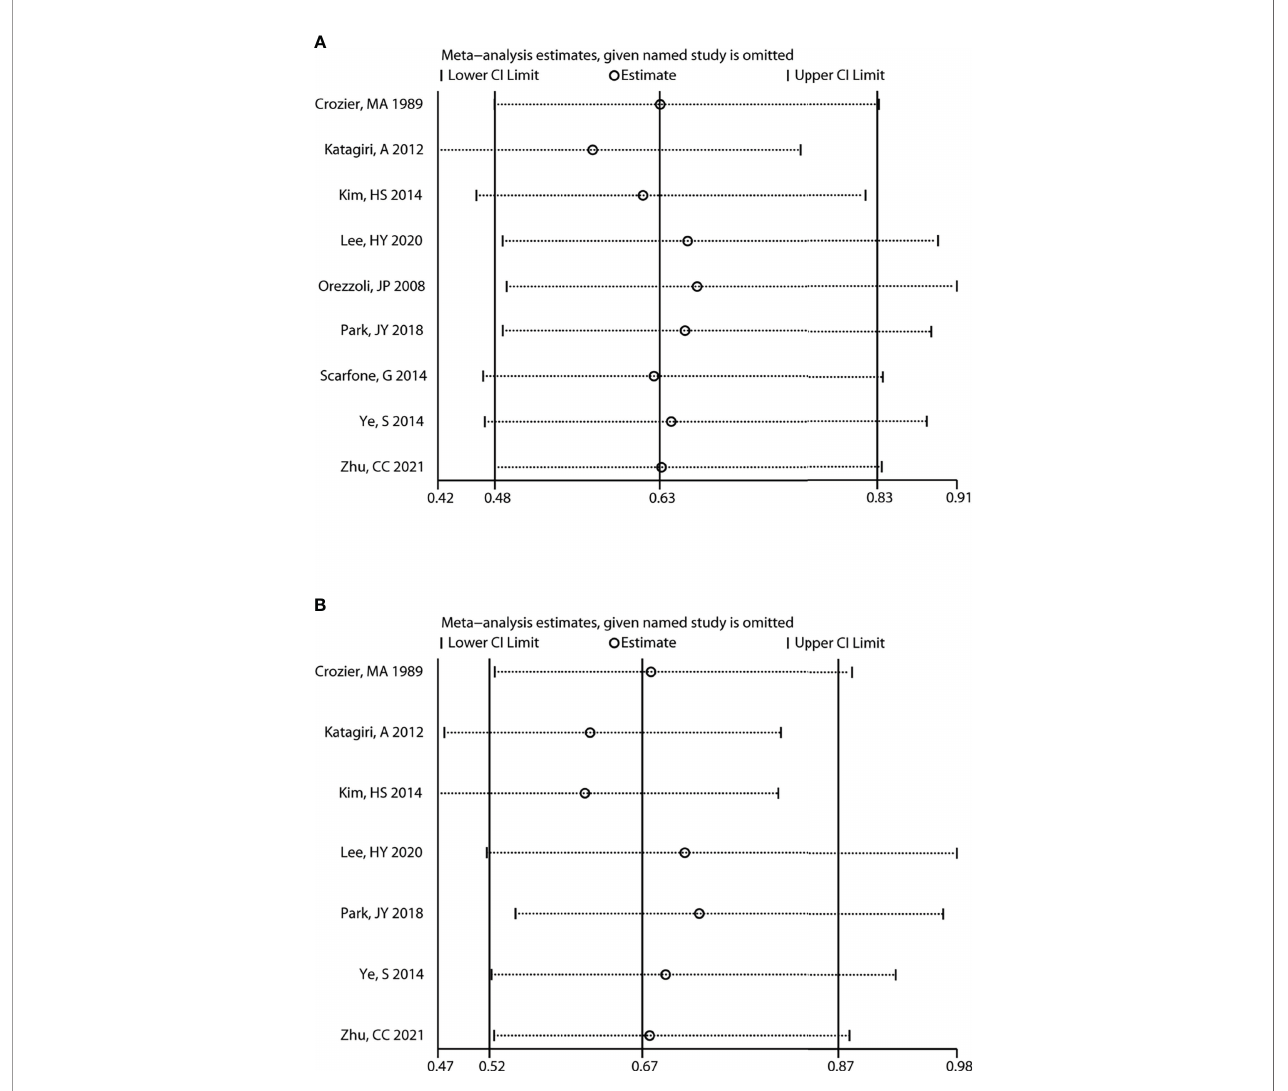
FIGURE 5 | Sensitivity analysis for the results of OCCC. Sensitivity analysis to evaluate the stability of the pooled results for assessing the impact of endometriosis on the overall survival (A) and progression-free survival (B) of OCCC patients. OCCC, ovarian clear cell